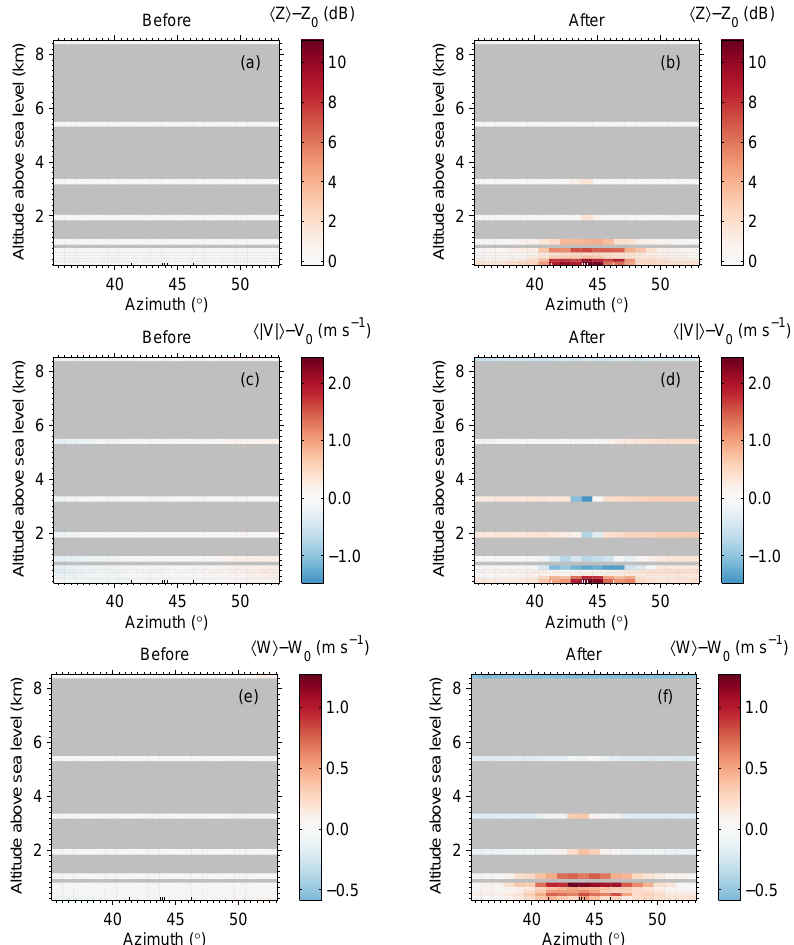
Figure 4. Difference in average reflectivity, (cid:104) Z (cid:105)− Z 0 ; difference in average absolute radial velocity, (cid:104)| V |(cid:105)− V 0 ; and difference in average spectrum width, (cid:104) W (cid:105)− W 0 , for all tilt angles (0 . 5 ◦ ≤ θ ≤ 40 ◦ ) before and after the construction of the Brunsmo wind farm. For each scan, Z 0 , V 0 , and W 0 were calculated as the mean value in azimuth (for the azimuth gates shown in the figure) of the corresponding spectral moment before the construction of the wind farm. For every scan, the data shown were taken from the range bin corresponding to the location of the wind turbines. For scans with higher tilt angles (2 . 5 ◦ ≤ θ ≤ 40 ◦ ) the average values of the two range bins nearest the wind turbines were used since for these scans the range resolution is 2 times that of the scans with lower tilt angles. The locations of the wind turbines are shown on the bottom of each plot as black or white vertical lines. The wind turbines are only in the radar line of sight for the scan with the lowest tilt angle but are nevertheless seen to have an impact on scans with higher tilt